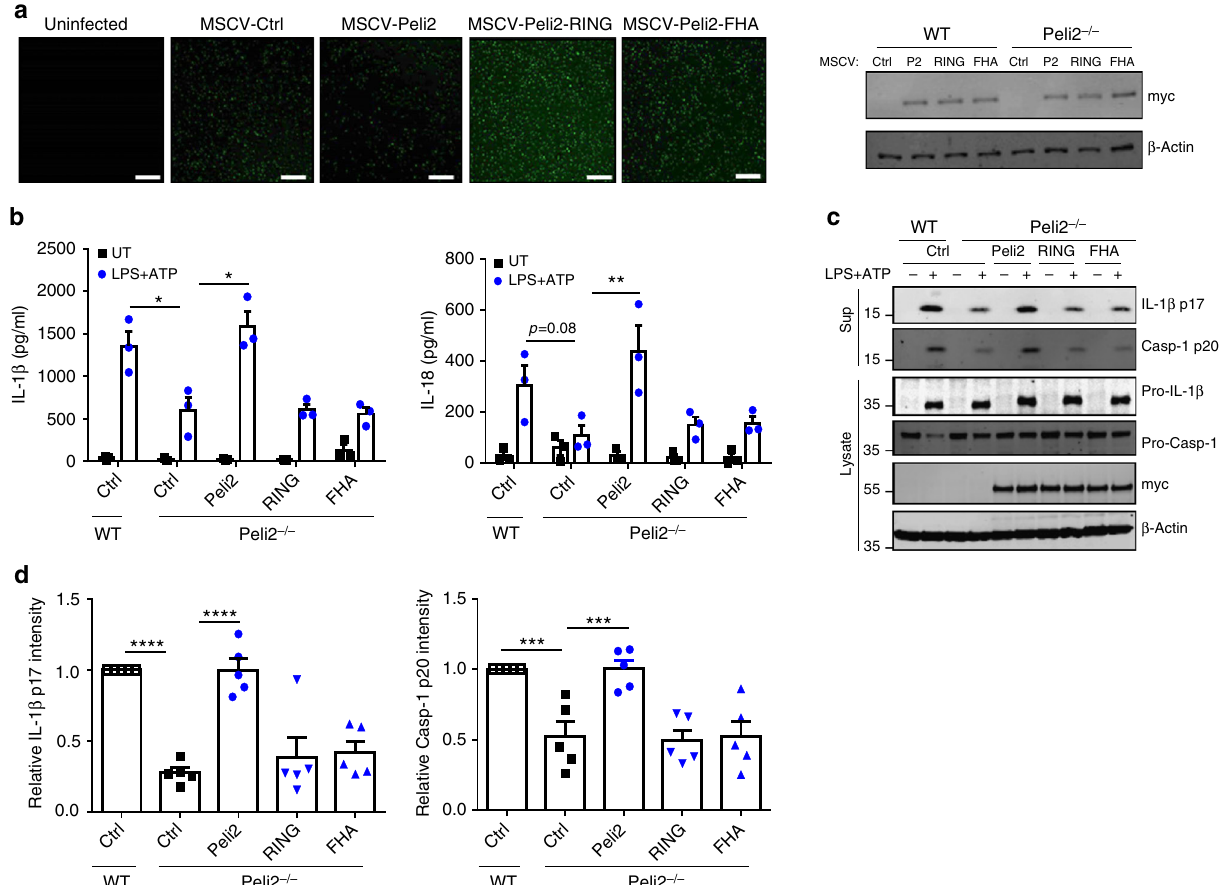
Fig. 5 The activation of the NLRP3 pathway is dependent on the FHA and RING-like domain of Pellino2. WT and Peli2 − / − BMDMs were infected with GFP- expressing murine stem cell virus (MSCV) as control (Ctrl) or with MSCV containing an expression construct encoding myc-tagged murine Pellino2 (Peli2), Pellino2 RING mutant (Peli2-RING), or Pellino2 FHA mutant (Peli2-FHA). a GFP expression (left panels) and immunoblot analysis of myc (right panel) (scale bar = 20 μ m). b ELISA of IL-1 β and IL-18 in medium from virus-infected WT and Peli2 − / − BMDMs stimulated with 100 ng/ml LPS for 3 h followed by 2.5 mM ATP for 1 h. c, d Immunoblot analysis ( c ) and densitometry analysis ( d ) of IL-1 β and Caspase-1 in medium (Sup) and cell lysates from virus-infected WT and Peli2 − / − BMDMs stimulated with 100 ng/ml LPS for 3 h followed by 2.5 mM ATP for 1 h. * P < 0.05; ** P < 0.01; *** P < 0.001; **** P < 0.0001 (paired, two-tailed Student ’ s t -test ( b ) or two-way ANOVA ( d )). Data are biological replicates that are representative of 3 – 5